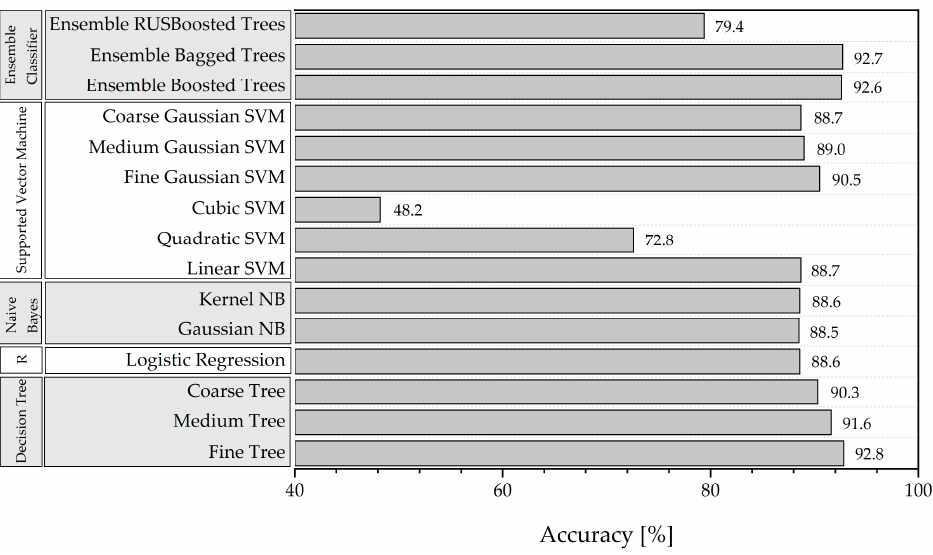
Figure 4. Tested algorithms used for training.